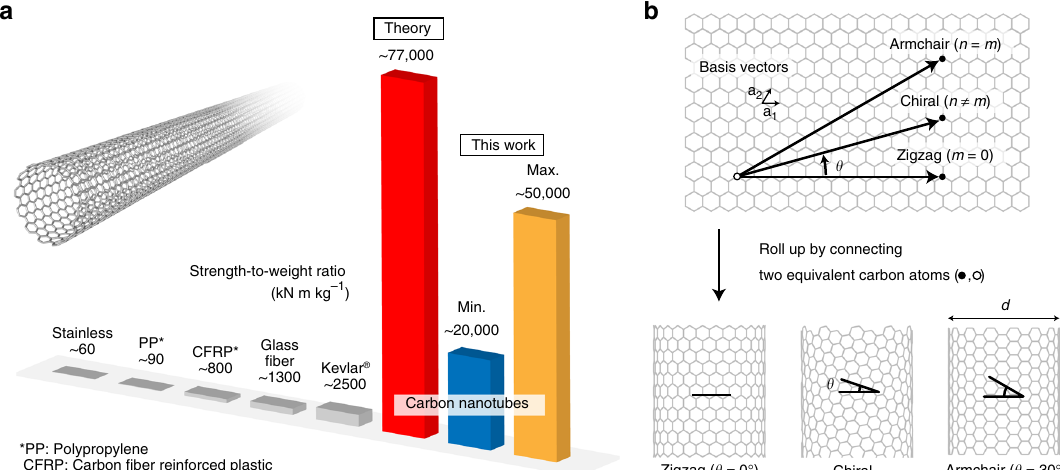
Fig. 1 Single-walled carbon nanotubes. a Theoretical (red) and experimental (blue and yellow, representing the minimum and maximum values obtained in this study, respectively) strength-to-weight ratios of single-walled carbon nanotubes, compared with those of typical structural materials. The inset shows a single-walled carbon nanotube. b Classi fi cation of the single-walled carbon nanotubes by their chiral indices ( n,m ), or diameter ( d ) and chiral angle ( θ ). The chiral indices ( n,m ) de fi ne the chiral vector (black arrows) that connects two equivalent carbon atoms in a graphene plane, and is represented as n a 1 + m a fi ned as the angle between the zigzag direction and circumference ( θ = 0° – 30°). Achiral 2 , where a 1 and a 2 are the basis vectors. The chiral angle is de nanotubes, where θ = 0 and 30°, are called zigzag and armchair nanotubes,